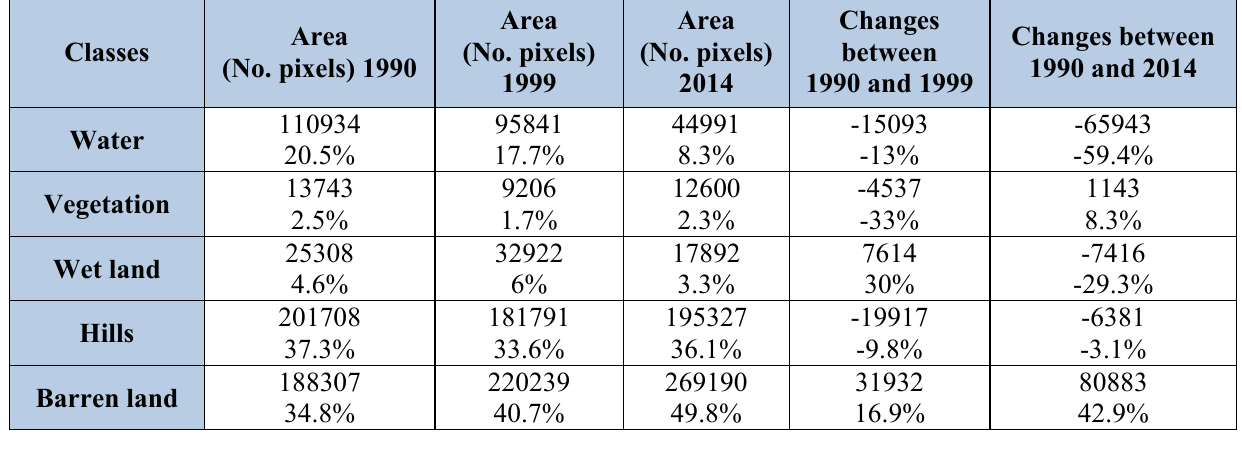
Table 1: The change in the years 1999, 2014 comparing with 1990 using mean value classification method.